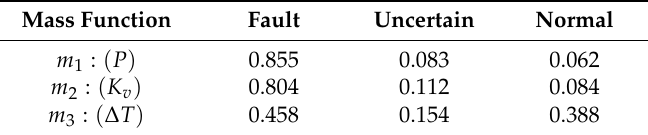
Table 9. The weighted mass functions.